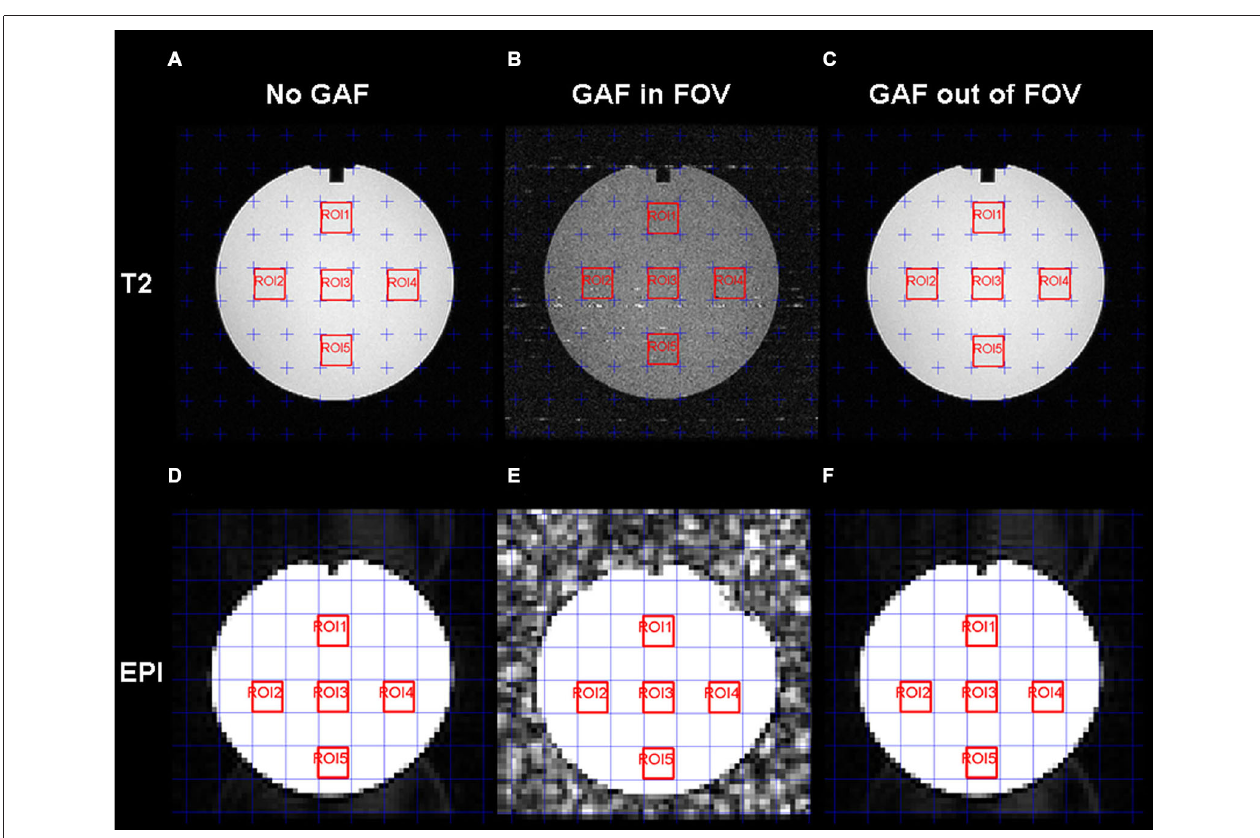
FIGURE 7 | T2-weighted (A,B,C) and EPI (D,E,F) images with the five ROIs delineated in red for the SNR estimation. For each series, the three conditions are displayed: No GAF (A,D) , GAF in FOV (B,E) , and GAF out of FOV (C,F) .